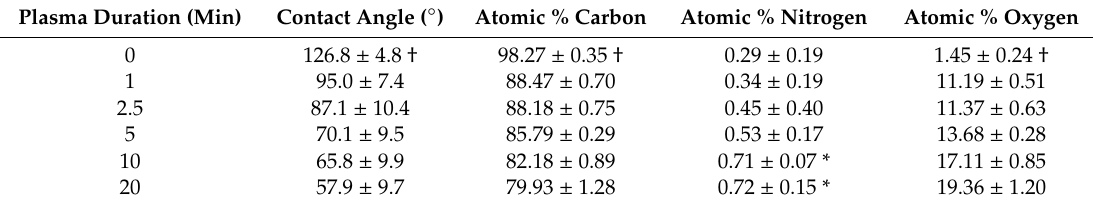
Table 1. E ff ect of plasma treatment duration on PP wettability, and surface